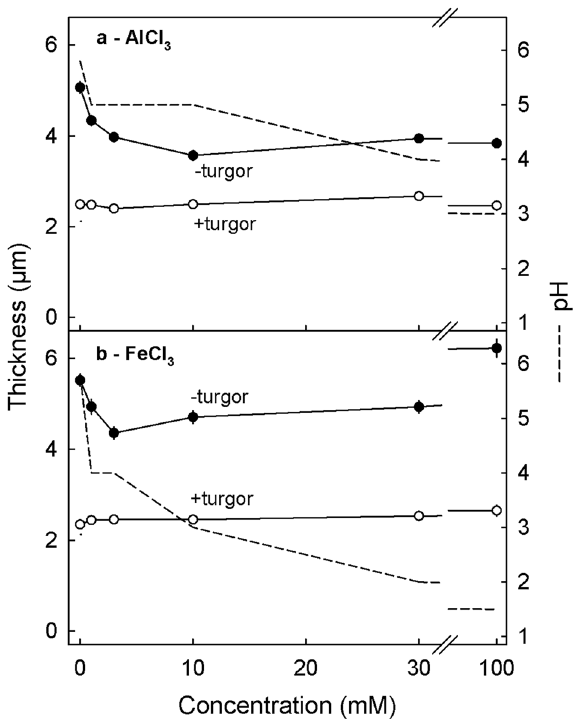
Figure 3. Effect of the concentration of AlCl 3 ( a ) or FeCl 3 ( b ) on the thickness of the anticlinal cell walls of excised epidermal segments (ES) of mature ‘Sam’ sweet cherry fruit. All ES were treated with a freeze/thaw cycle to release turgor followed by an incubation in one of a range of concentrations for 48 h. The dashed lines indicate the solution pH after incubation.